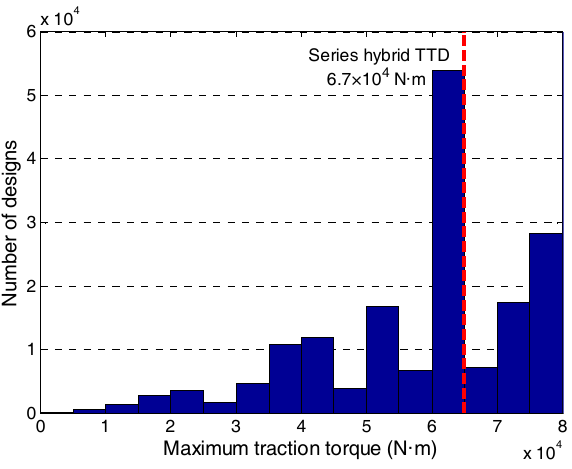
Figure 8. Maximum traction torque distribution of all surviving designs.